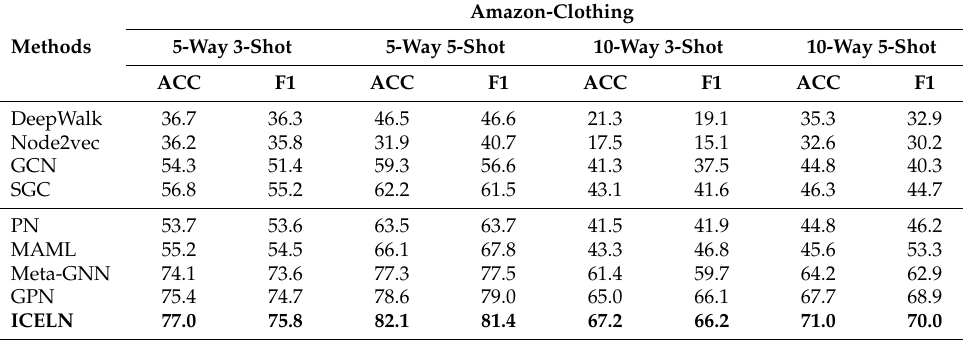
Table 4. The few-shot node classification ACC and F1 score results on Amazon-Clothing.